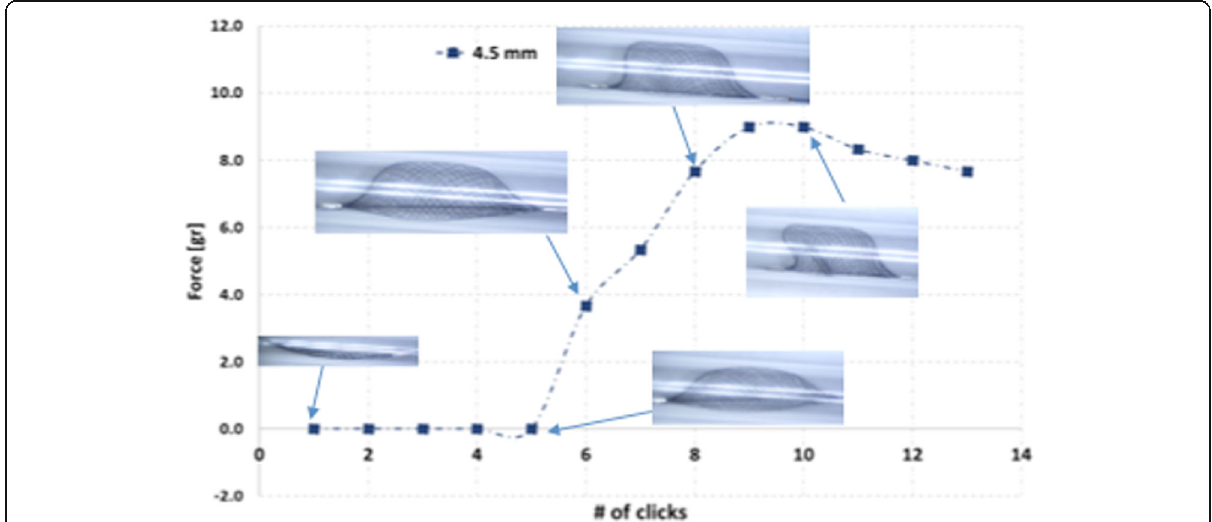
Fig. 10 When placed into tubes below the maximal diameter of the Cascade device the force generated by the device gradually increases to a maximum. Further continued expansion of the device results in deformity of the braided structure and a decrease in the force applied to the